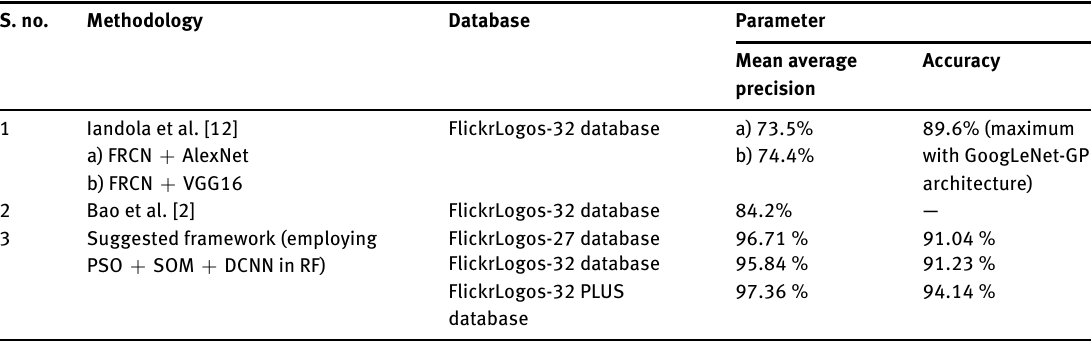
Table 9: Comparison of the Approaches of Iandola et al. [12] and Bao et al. [2] with the Suggested Framework. S.